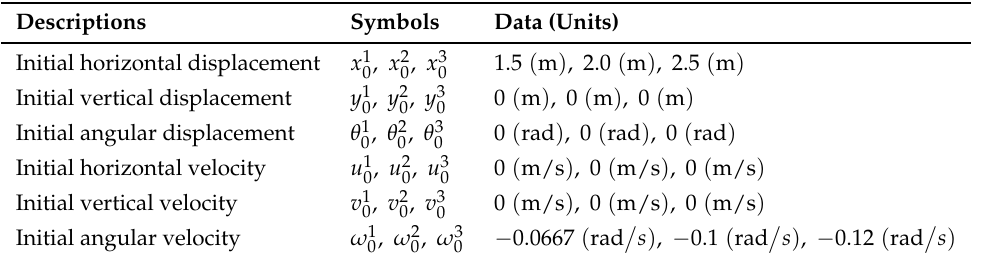
Table 3. Sets of initial conditions.